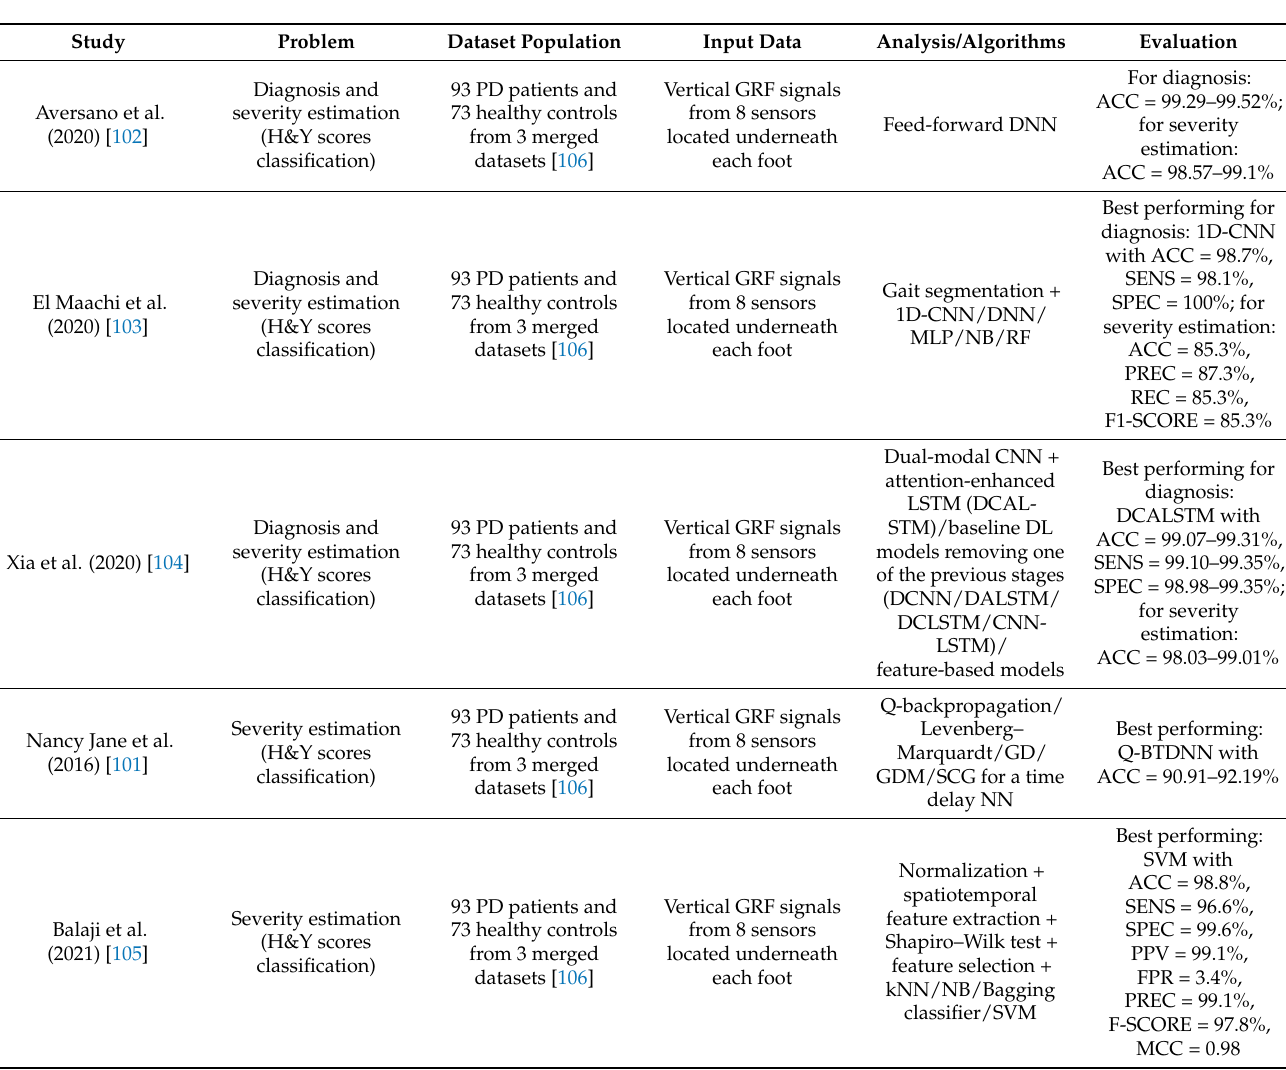
Table A2. Studies based on pressure and force